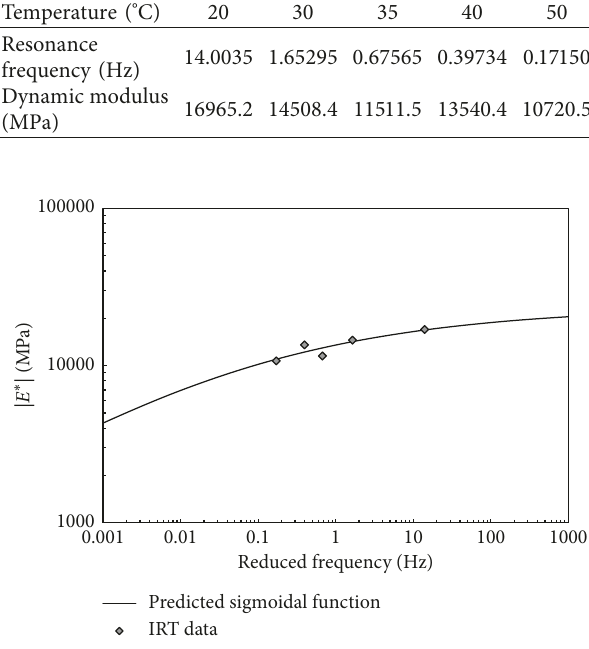
Figure 7: Comparison between measured data and predicted sigmoidal function from IRT.